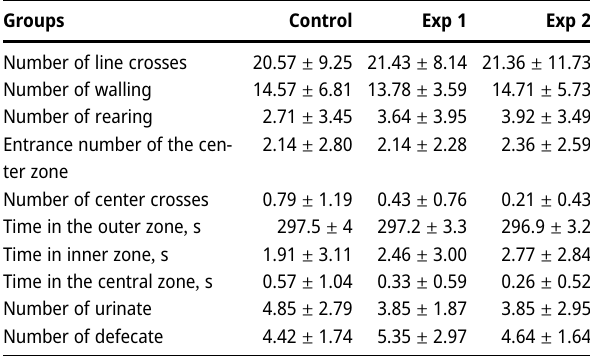
Table  : Intergroup comparison of open fi eld test